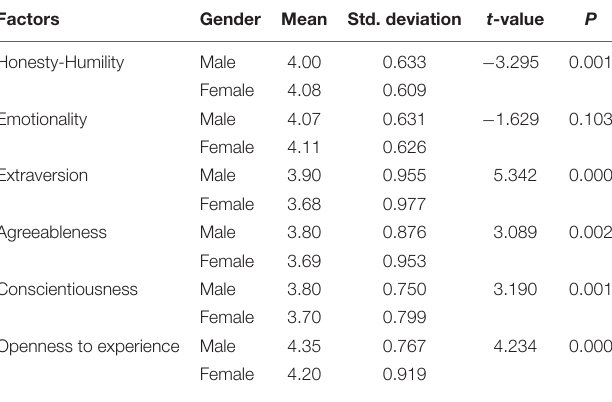
TABLE 5 | Comparison between male and female higher achievers’ students’ personality